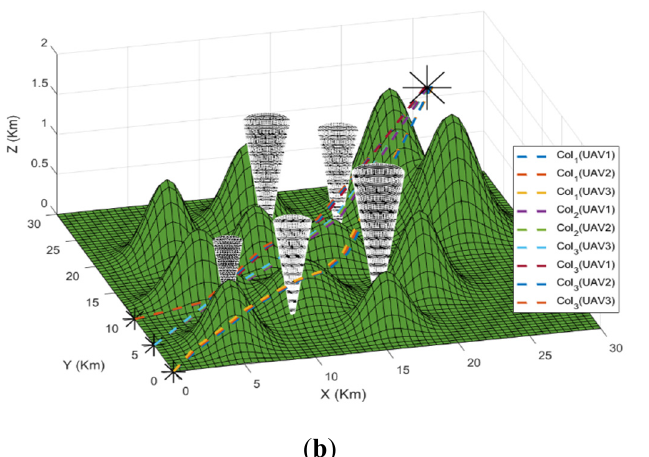
Figure 8. Simulation Results with Peaks and Tornadoes; ( a ) 3D simulation seen from one point of view ( b ) 3D simulation from another point of view.